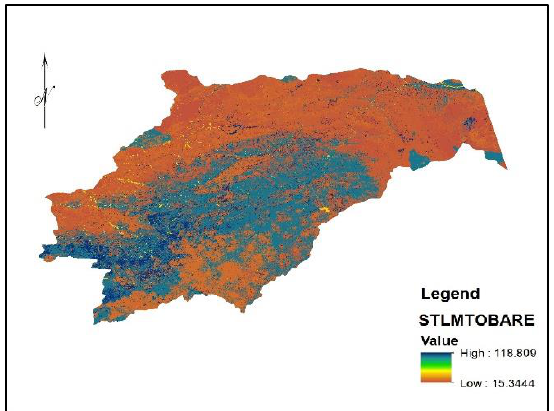
Figure 7: Map showing from Settlement to Bareland (STLMTOBARE) scenario in